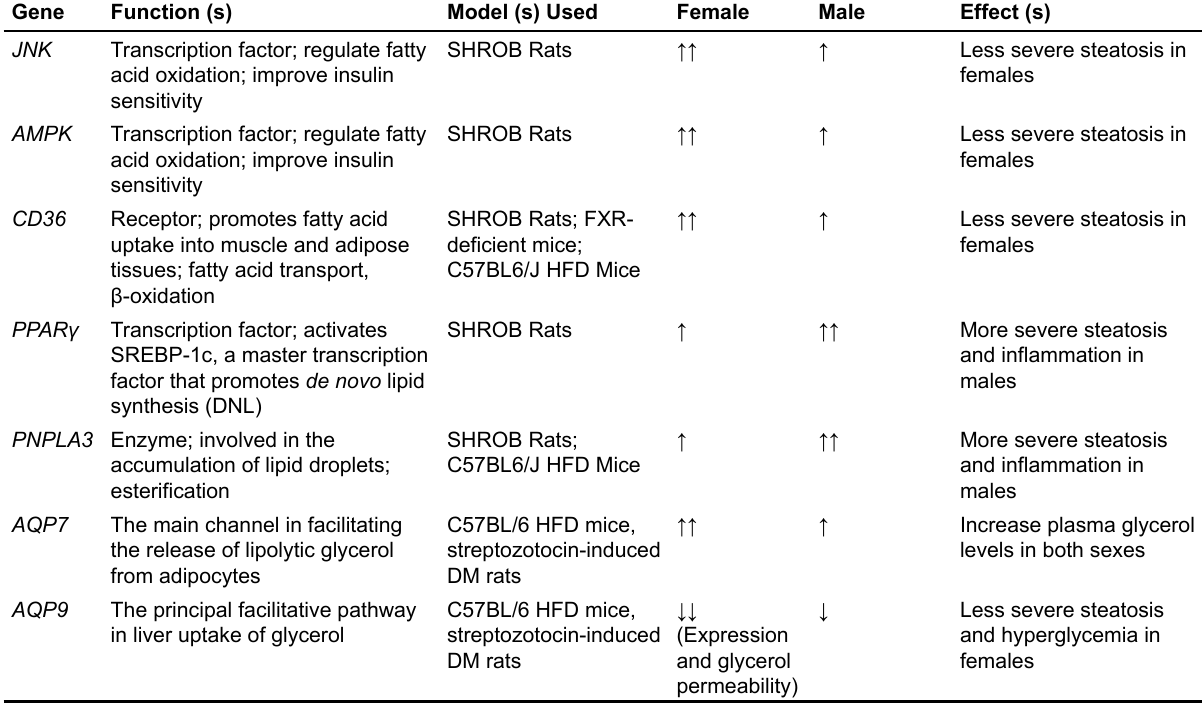
points to a more efficient fatty acid transport, lipid utilization, and greater insulin sensitivity, all of which contribute to reducing steatosis in female livers. Table 1. Sexually dimorphic hepatic genes associated with NAFLD